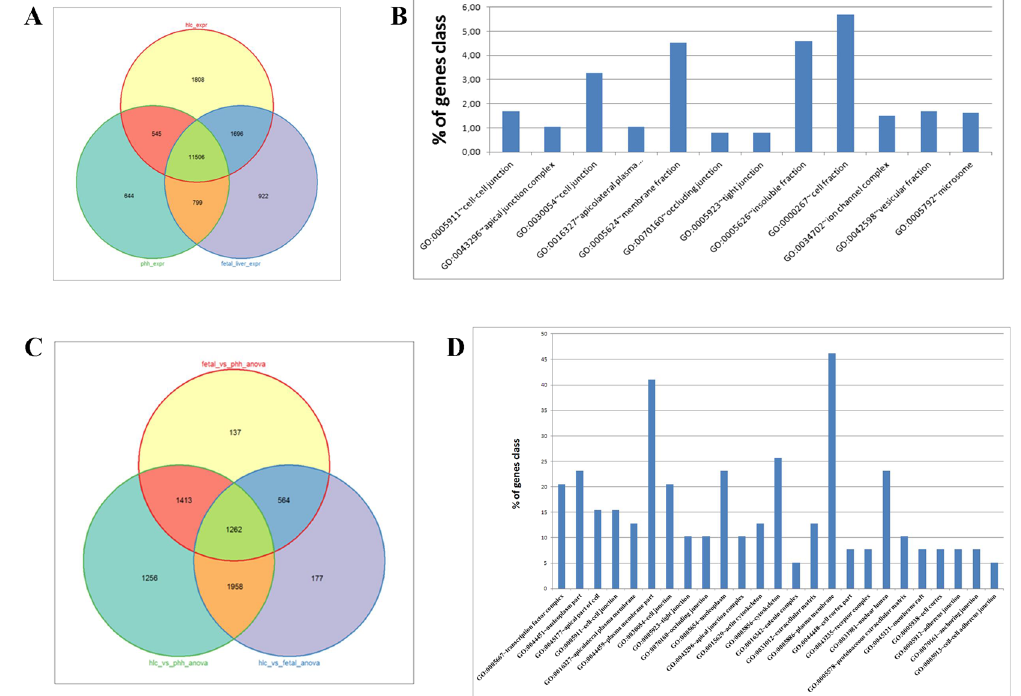
Figure 5. Comparative transcriptome profile analyses. ( A ) Venn diagram of HLCs, fetal liver and PHH. ( B ) GO cellular components of HLC exclusively expressed genes (Fisher extract p < 0.01). ( C ) Venn diagram of fetal liver vs. PHH anova, HLC vs. fetal liver anova and HLC vs. PHH anova. ( D ) GO cellular components of HIPPO pathway genes exclusively expressed genes (Fisher extract p < 0.01) in the intersection of HLC vs. fetal liver anova and HLC vs. PHH anova (intersection with 1958